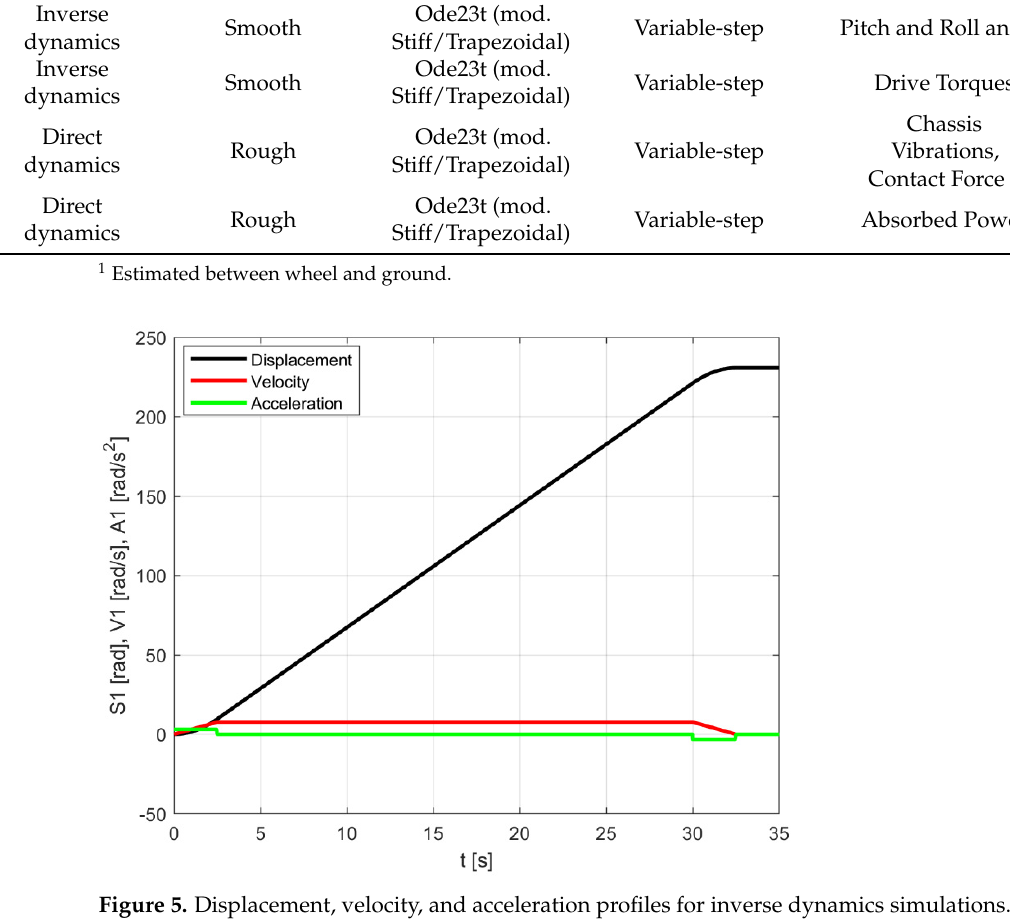
Figure 5. Displacement, velocity, and acceleration profiles for inverse dynamics simulations.